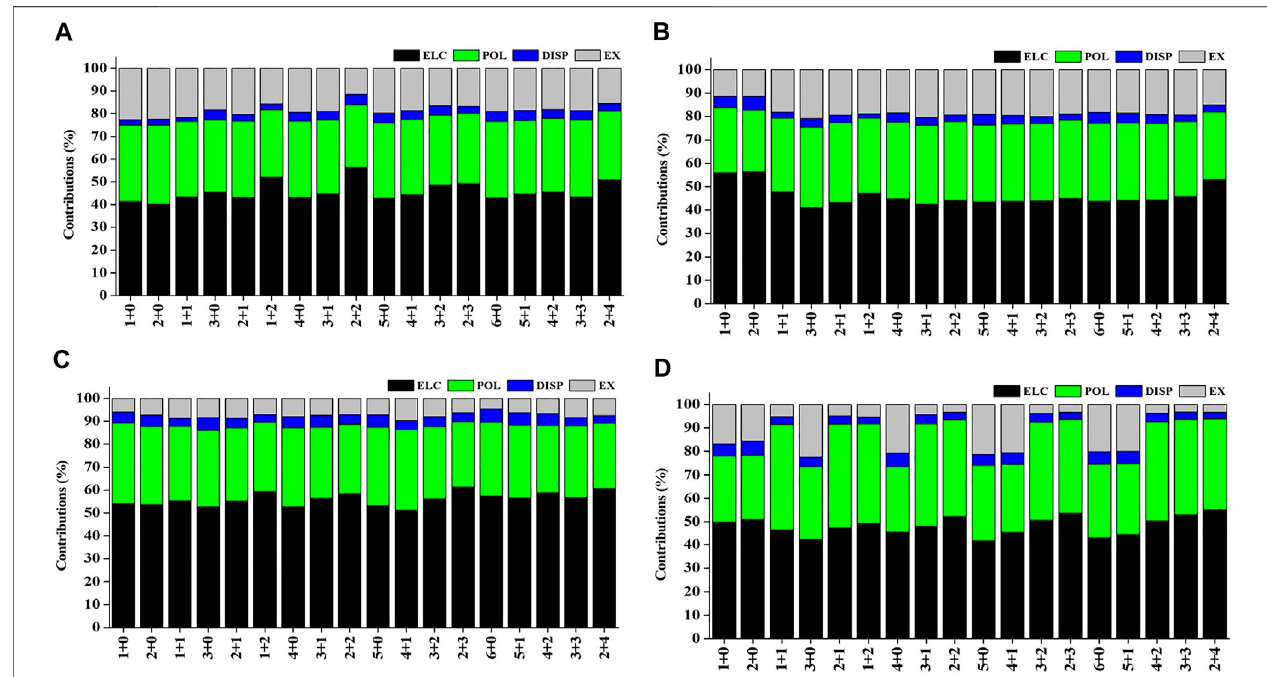
FIGURE 10 | Percentage contribution of energy components such as electrostatic (ELC), polarization (POL), dispersion (DISP), and exchange (EX) into the interaction energy of the (A) monocationic singlet state (MSS), (B) monocationic triplet state (MTS), (C) dicationic doublet state (DDS), and (D) tricationic singlet state (TSS) of Sc z+ (OH 2 ) n ; z (cid:2) 1 – 3 and n (cid:2) 1 – 6 complexes obtained using the LMO-EDA scheme at B3LYP/6-311G**//MP2/6-31G* for hydrogen (H) and oxygen (O) and B3LYP/cc-pVTZ//MP2/6-31G* for the Sc z+